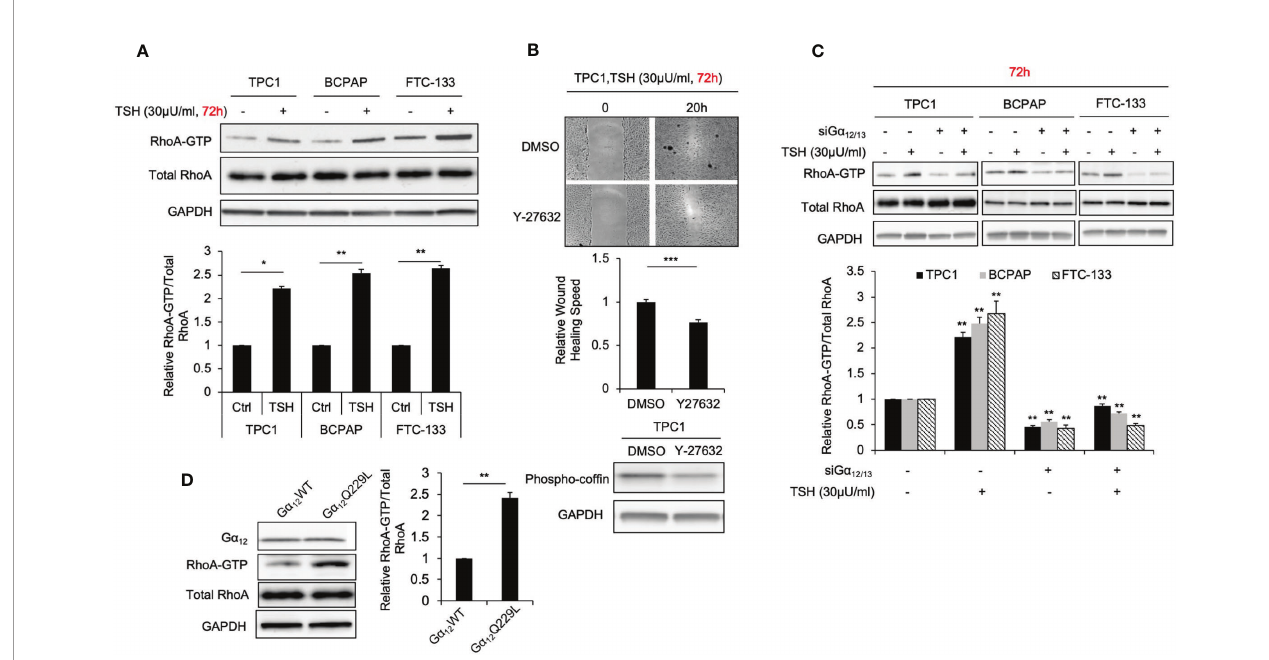
FIGURE 2 | TSH increasing RhoA activation and cell migration is G a 12/13 dependent. (A) Immunoblots of RhoA and GAPDH from total cell lysates and RhoA after GST-Rhotekin pull-down (RhoA-GTP form) in TPC1, BCPAP and FTC-133 cells. Bar graphs, normalized ratios of active RhoA relative to total RhoA levels. Data represent means ± SEM of 3 independent experiments. (B) Wound-healing assay for TPC1 cells with treatment of 30 m U/mL TSH and 30 m M Y27632 or control. Bar graph Data represents relative wound healing rate of TPC1 cells with treatment of 30 m U/mL TSH and 30 m M Y27632 normalized with control. Immunoblots of phosphor-cof fi n and GAPDH in TPC1 cells incubated with 30 m U/mL TSH and 30 m M Y27632 for 72 hours. and Data represent means ± SEM of 3 independent experiments. (C) Immunoblots of RhoA, G a 12 and GAPDH from total cell lysates and RhoA after GST-Rhotekin pull-down (RhoA-GTP form) in TPC1, BCPAP and FTC-133 transiently transfected with non-targeting siRNA (siNT) or G a 12 and G a 13 siRNA (si G a 12/13 ) with treatment of 30 m U/mL TSH. GAPDH is used as a loading control for normalization. The bar graph represents normalized ratios of active RhoA relative to total RhoA levels. (D) Immunoblots of RhoA, G a 12 and GAPDH from total cell lysates and RhoA after GST-Rhotekin pull-down in TPC1 stably transfected with G a 12 WT or G a 12 Q229L. Bar graph, normalized ratios of active RhoA relative to total RhoA levels. * P < 0.05, ** P < 0.01, *** P <